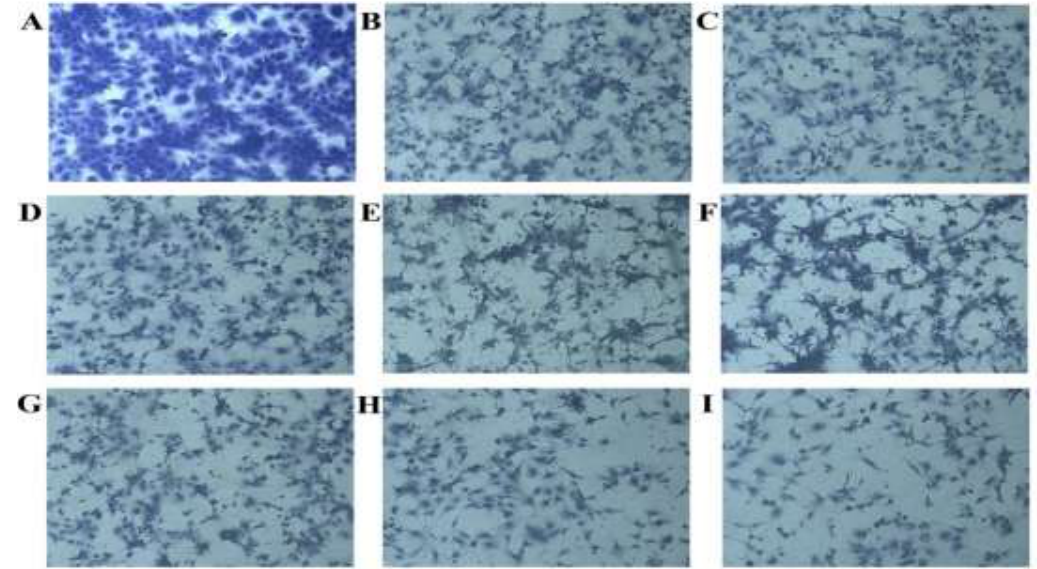
Figure 7: The cytotoxicity effect of the NDV on AMGM5 cell lines by utilizing the eight MOI of the virus. (A) Control not infected cells, (B) infected with the 0.1 MOI of NDV; (C) infected with the 0.3 MOI of NDV; (D) infected with the 0.5 MOI of NDV; (E) infected with the 1 MOI of NDV; (F) infected with the 3 MOI of NDV; (G) infected with the 5 MOI of NDV; (H) infected with the 10 MOI of NDV; and (I) infected with the 20 MOI of